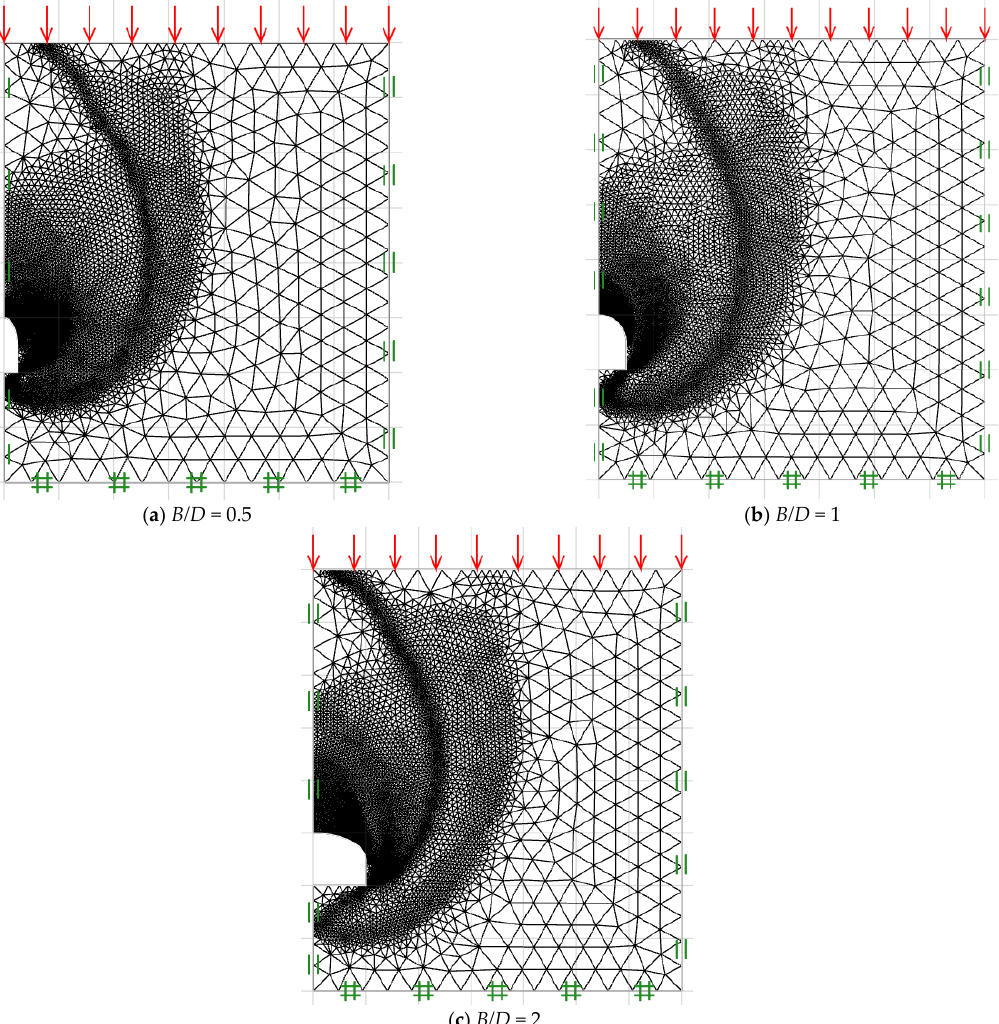
Figure 7. Final adaptive meshes for various B/D ( C/D = 5, γ D/c' = 0 and ϕ = 25°).